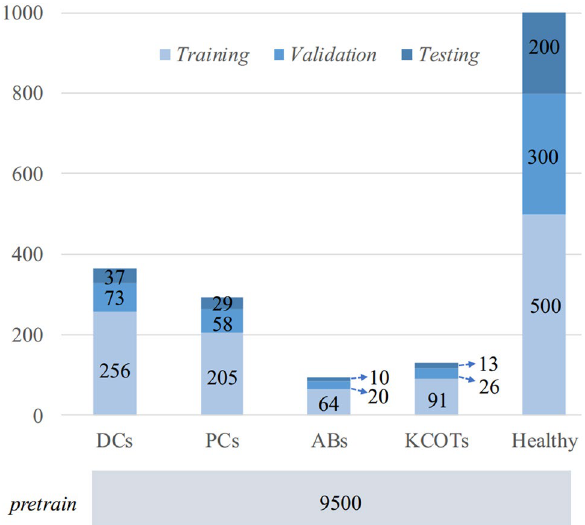
Figure 1. The dataset statistic of panoramic radiographs. KCOTs: Keratocystic odontogenic tumors; Abs: Ameloblastomas; DC: dentigerous cysts; PC: periapical cysts. In our experiment, healthy panoramic radiographs are split into 9500 samples for pretraining and training, 300 samples for validation, and 200 samples for testing. For lesion samples, 70%, 20%, and 10% samples are used for training, validation, and testing.